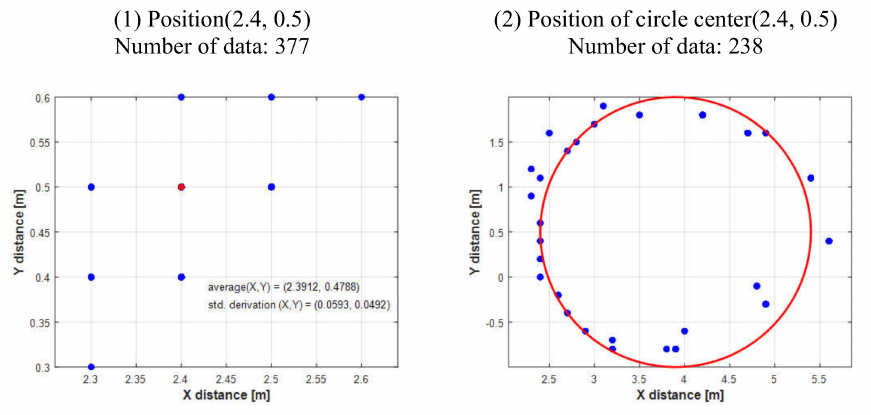
Figure 21. USBL test